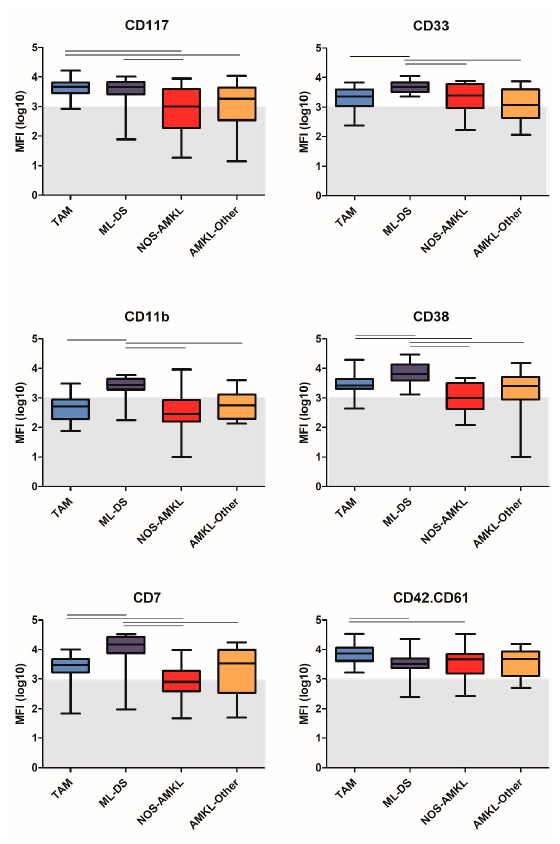
Figure 4. Univariate analysis of marker expression between the four AMKL subgroups. Data represent the MFI values after log10 transformation. The lines the on top of the figures represent statistically significant differences ( p < 0.05) between the two groups. The grey zone indicates MFI levels < 1000; markers with such MFI values were considered to be